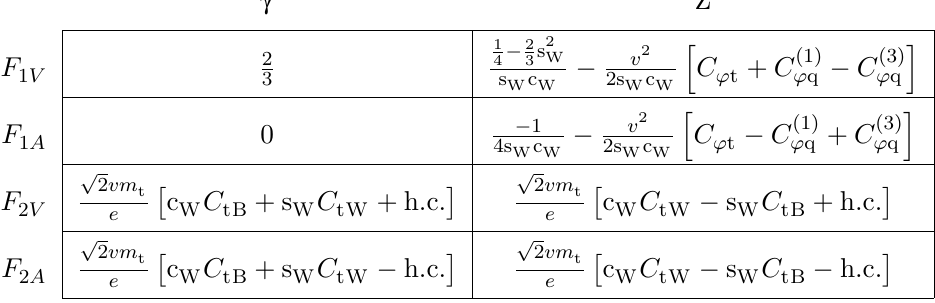
and c , respectively, W W